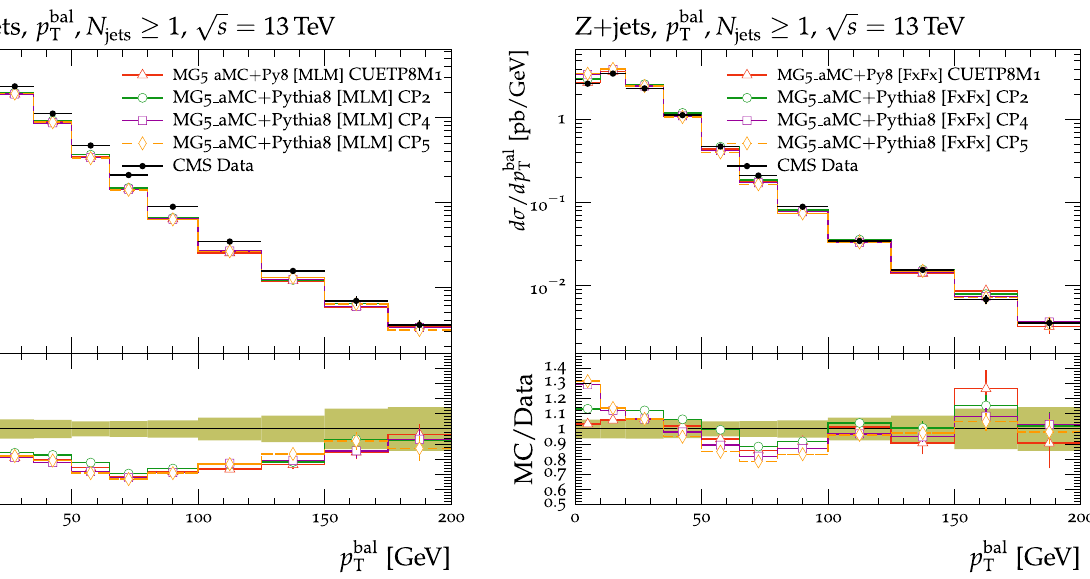
Fig. 23 Comparison with the measurement [71] of the p T balance pre- dicted by mg5 _a mc + pythia 8 with k T –MLM merging (left) and FxFx merging (right) for the different tunes for events with at least one jet. Tunes CP1 and CP3 are not shown in the plot but they present a similar behaviour as tunes CP2 and CP4, respectively. The ratios of simulations